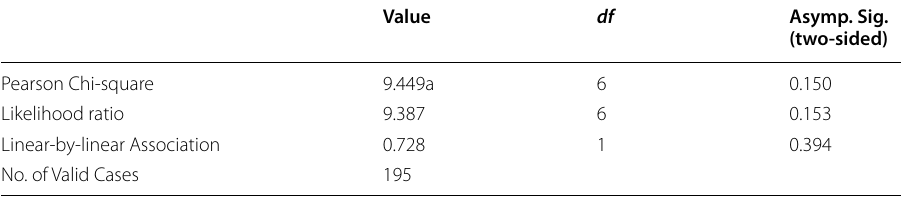
Value df Asymp. Sig. (two‑sided) Pearson Chi-square 9.449a 6 0.150 Likelihood ratio 9.387 6 0.153 Linear-by-linear Association 0.728 1 0.394 No. of Valid Cases Source Field survey result, 2021